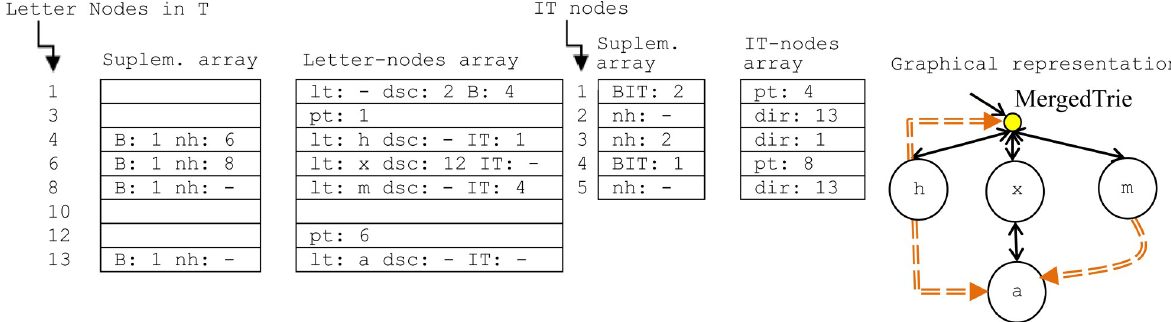
Fig 2. Sequential and graphical representations of the MergedTrie with the words h , hax , max ( lt : letter; dsc : descendant index; IT : inter-trie index; pt : index of the parent node; nh : index of the following hash collision; dir : IT index to suffix letter-node; B : size of hash table of letter- nodes; BIT : size of hash table of IT links; root of T: